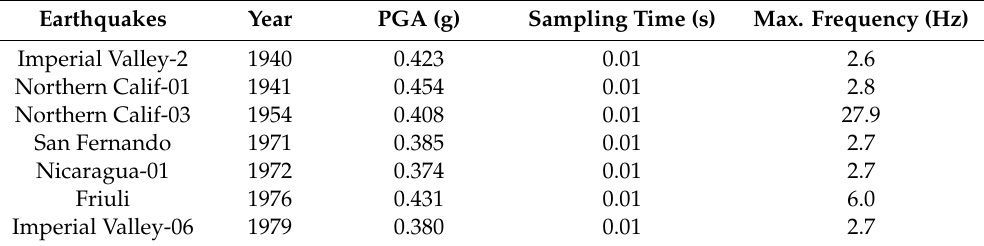
Figure 19. Imperial Valley-06: ( a ) Time history; ( b ) Response spectrum. Table 6. Characteristics of seismic